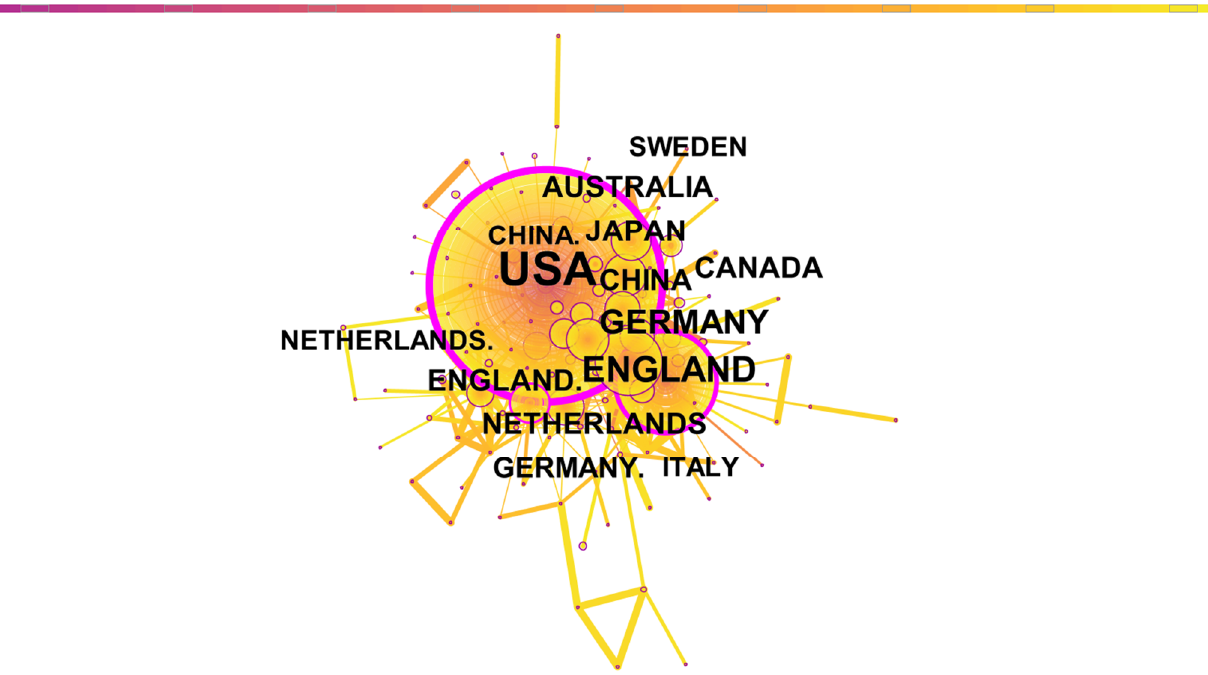
Figure 4. Map of the country co-authorship network in crisis and risk communication research.